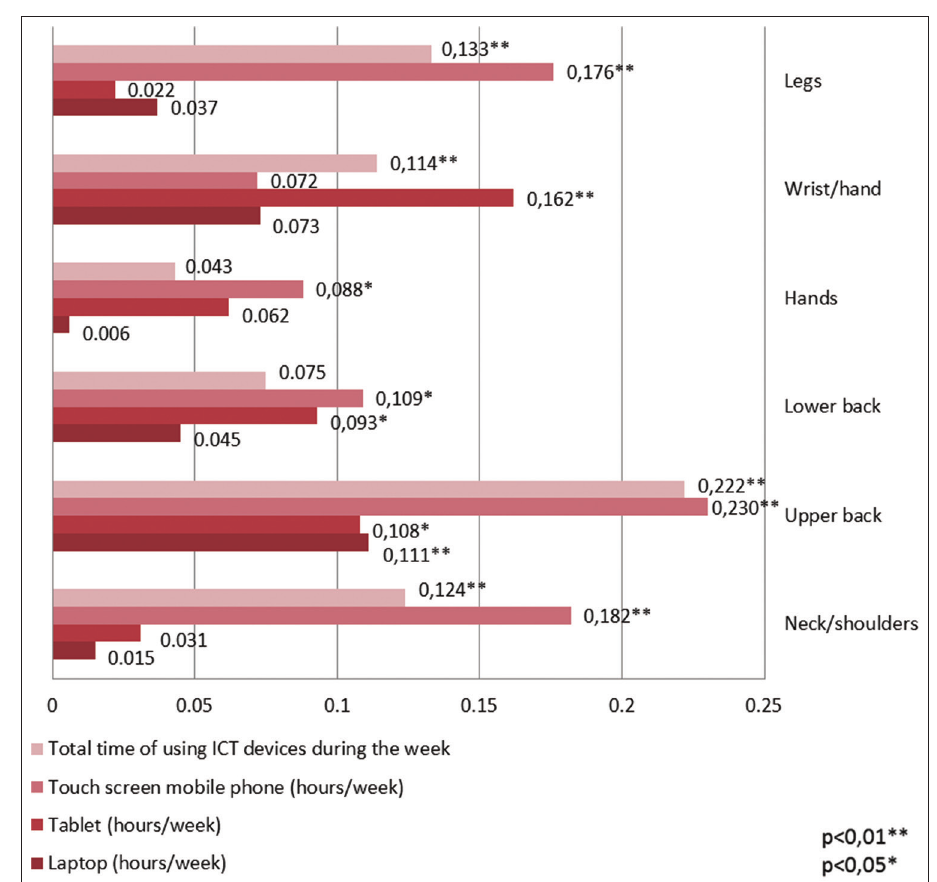
CHART 2. Correlation analysis of the pain intensity during the last month of statistically significant variables in relation to the time of used ICT